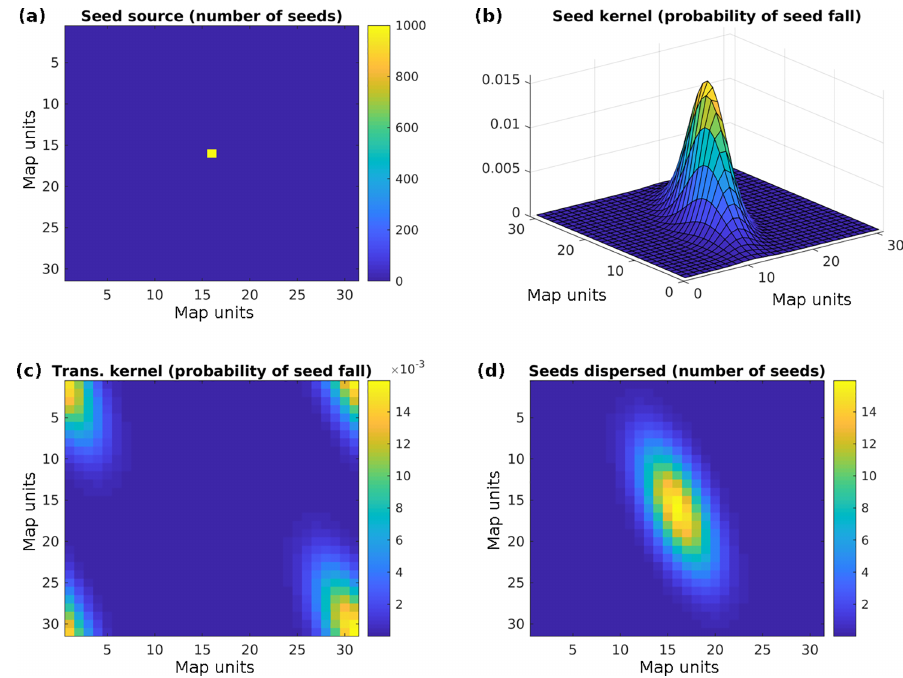
Figure 1. (a) Seed source. (b) Example of a seed dispersal kernel (here a non-symmetric kernel is assumed), (c) transformed seed dispersal kernel, and (d) seed distribution after convolution.